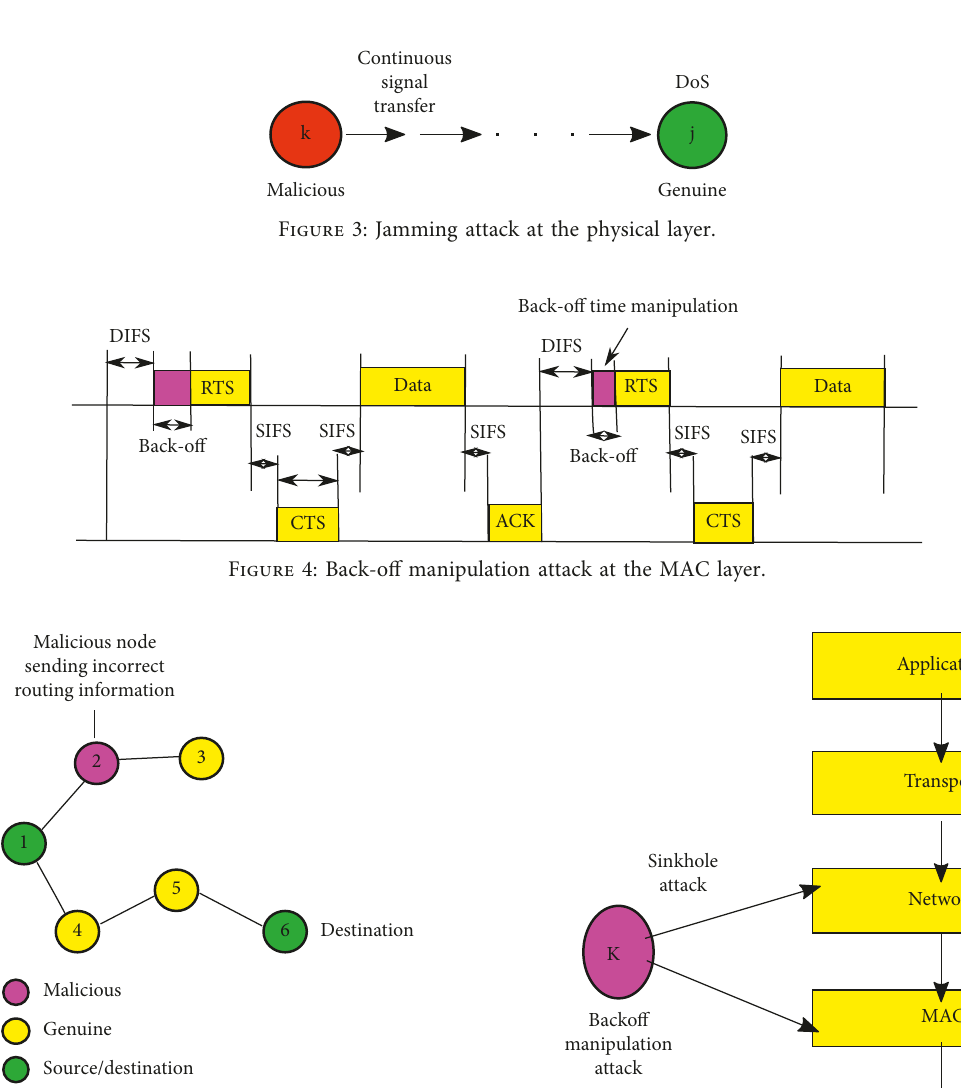
Figure 5: Sinkhole attack at the network layer.